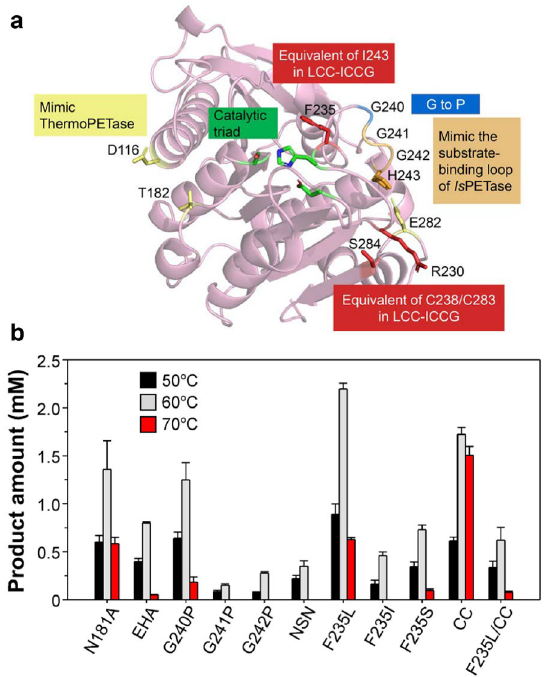
Fig. 3 Engineering of variant N181A. a The overall structure of Ct PL‑DM (PDB ID, 8IAN) in cartoon representation. Residues selected for engineering are displayed in sticks, with each color correspond to the mutation strategies indicated in the colored box. The residues comprising the catalytic triad (green box) are shown as sticks. b De‑glycosylated P. pastoris ‑expressed recombinant protein of each variant were incubated with GfPET film at indicated temperature for 18 h. The total amount of hydrolytic products (MHET and TPA) were measured and presented as